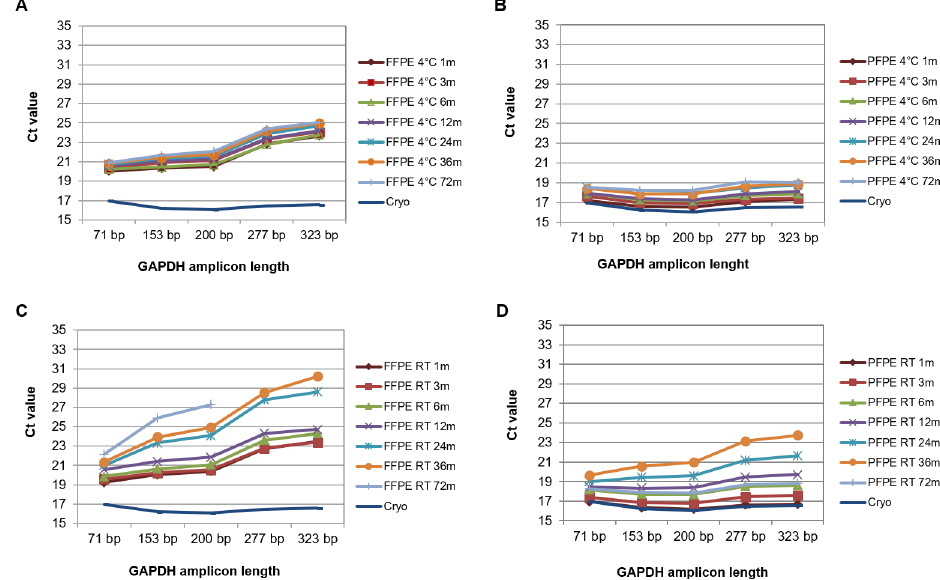
Fig 4. RT-qPCR-performance is independent from storage time in PET blocks stored at 4˚C. Human FFPE (A and C) and PFPE (B and D) tissue (case #1, soft tissue) were stored at 4˚C (A and B) or at room temperature (C and D) for up to 6 years prior to RNA extraction. Amplification of human GAPDH gene fragments ranging from 71 to 323 base pairs (bp) was performed in SYBR-Green RT-qPCR assays. Missing data points represent no specific amplification